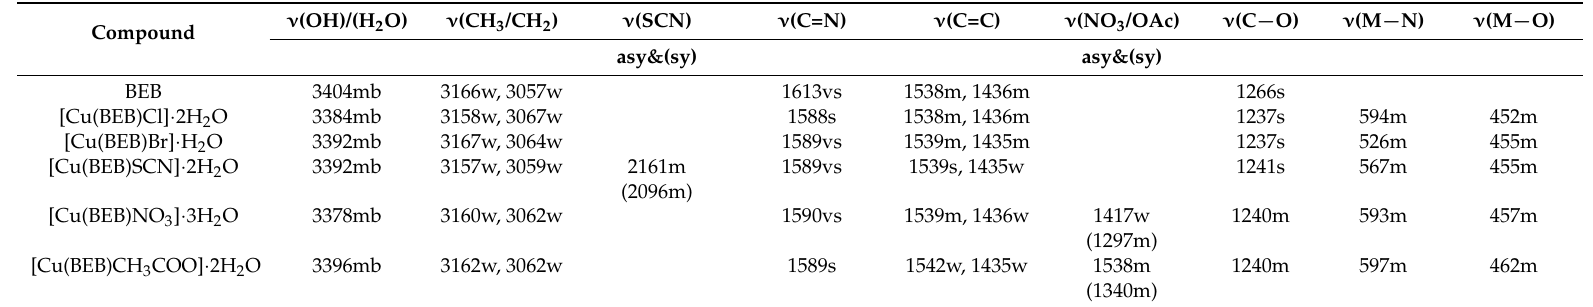
Table 2. FT-IR Spectral data of the Schiff base [BEB] and its metal